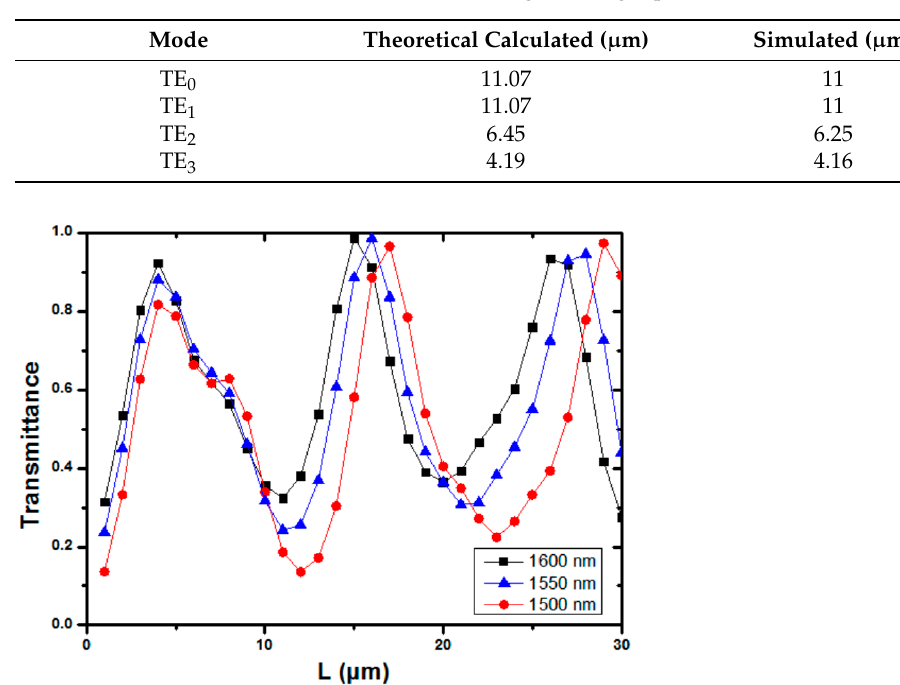
Table 2. Theoretical calculated and simulated waveguide length period.